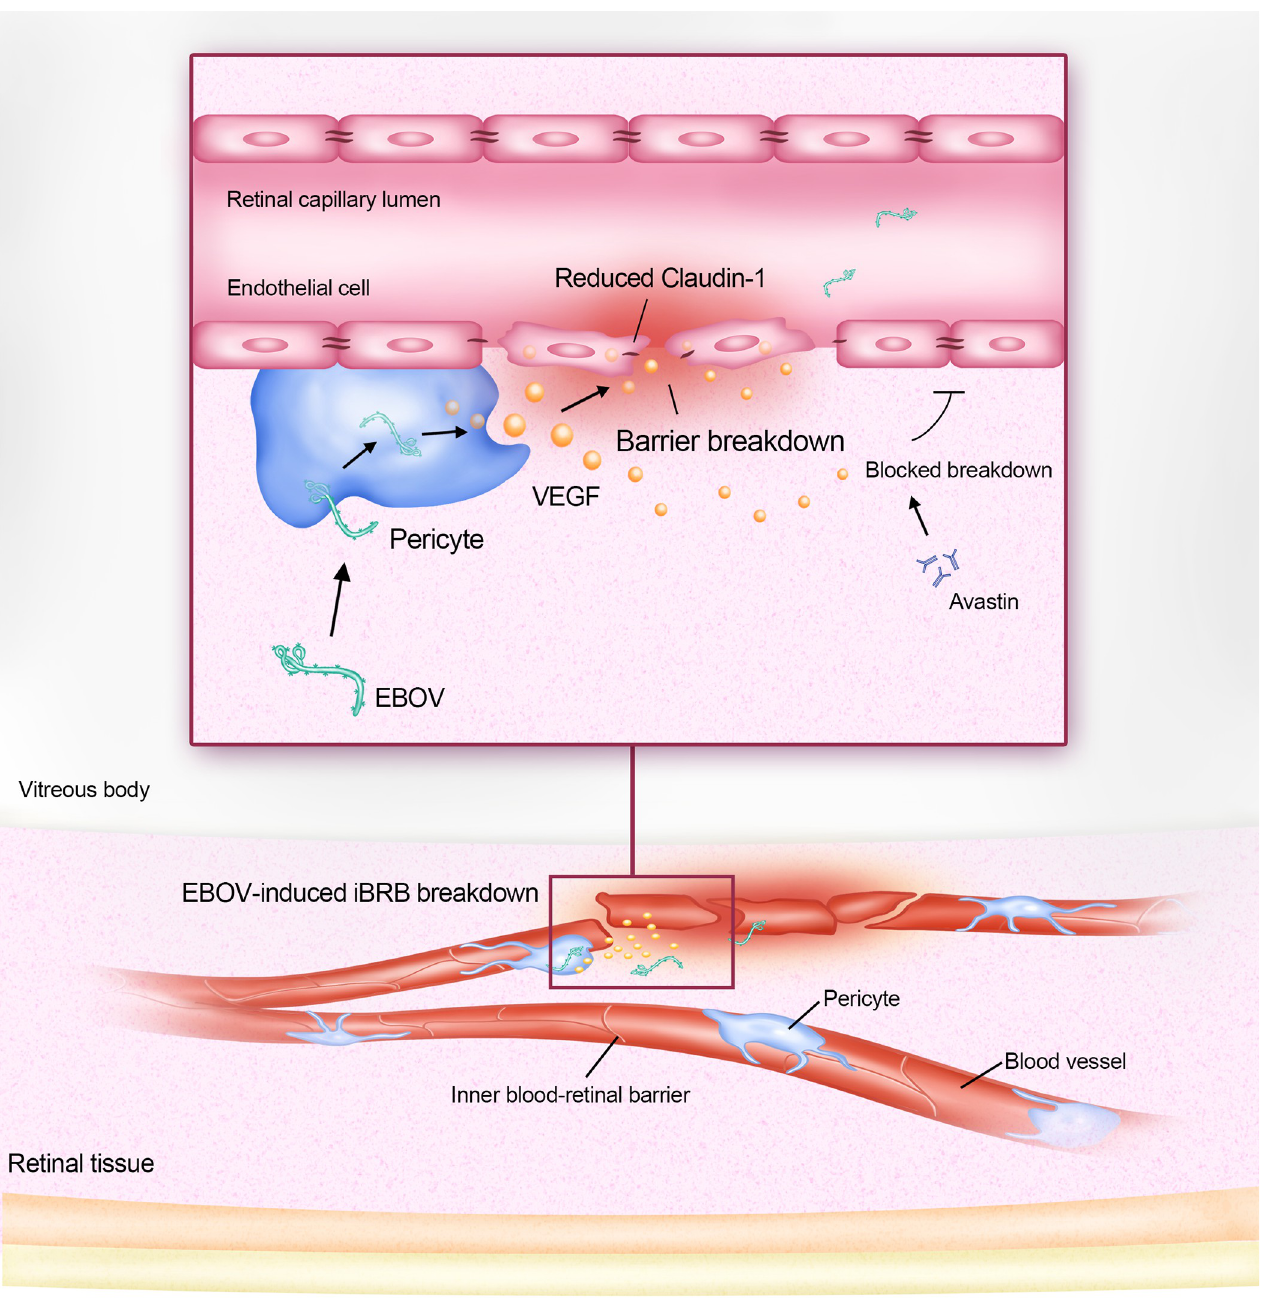
Fig 8. Model for the iBRB breakdown affected by EBOV. EBOV stimulates pericytes to secrete VEGF to cause the iBRB breakdown. VEGF disrupts iBRB through downregulation of the tight junction protein claudin-1. The VEGF antibody Avastin can reduce the effect on VLP-induced iBRB breakdown. mouse rabbit claudin-1 antibody (Abcam, ab211737), rabbit occludin antibody (Abcam, ab216327), anti-ZO-1 (Thermo Fisher, 1A12), rabbit VEGF antibody (Beyotime, AV202), and Alexa Fluor 488-and555-labeled goat anti-mouse and anti-rabbit IgG (Cell Signaling Technology).